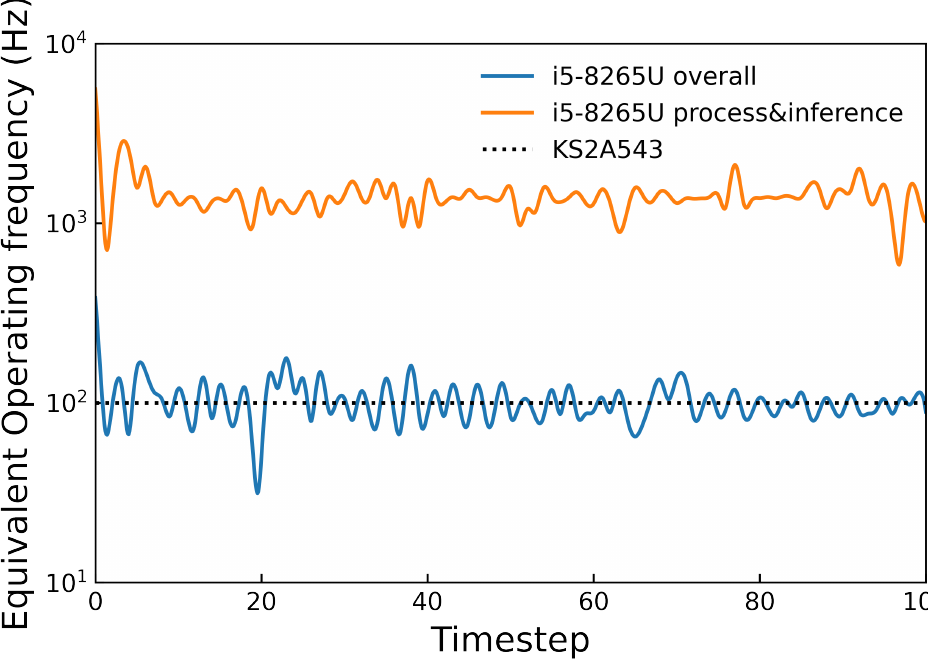
Figure 14. Operating frequency of the proposed device. Equivalent overall (blue) and process (orange) frequency on HP 430G6 with an i5-8265U CPU. The theoretical average sampling rate of the image sensor KS2A543 used in the proposed device is denoted by the dotted line at 100